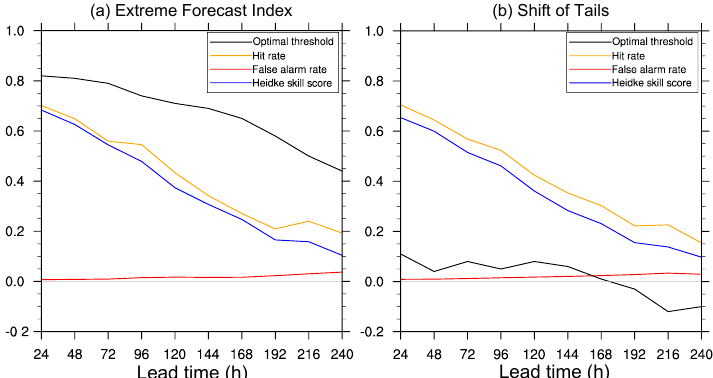
Figure 9. Optimal threshold and corresponding hit rate ( H ), false alarm rate ( F ) and Heidke skill score for the Extreme Forecast Index ( a ) and the Shift of Tails ( b ) to predict gusts exceeding the local 98th percentile in ERA-Interim.